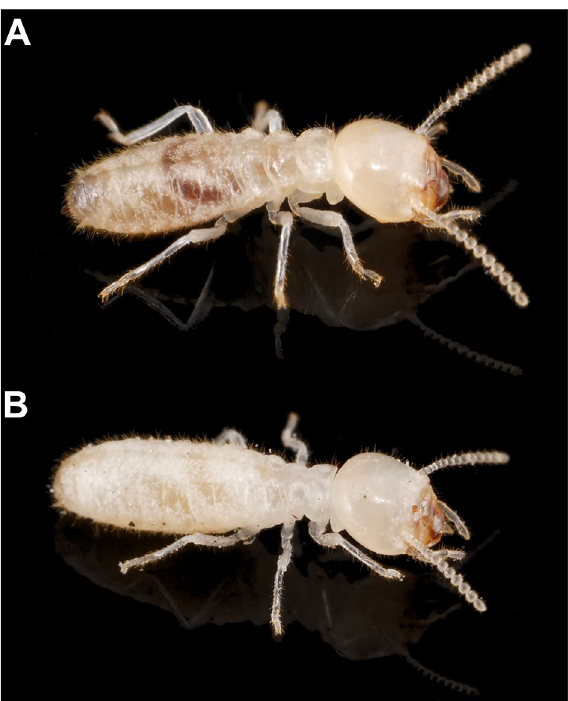
Figure 5. Photographs showing individual termite gut content as visible through the cuticle in termites reared with access to organic soil ( A ). The dark soil organic matter is clearly visible in the gut of the termite as opposed to those reared on only sand and wood ( B